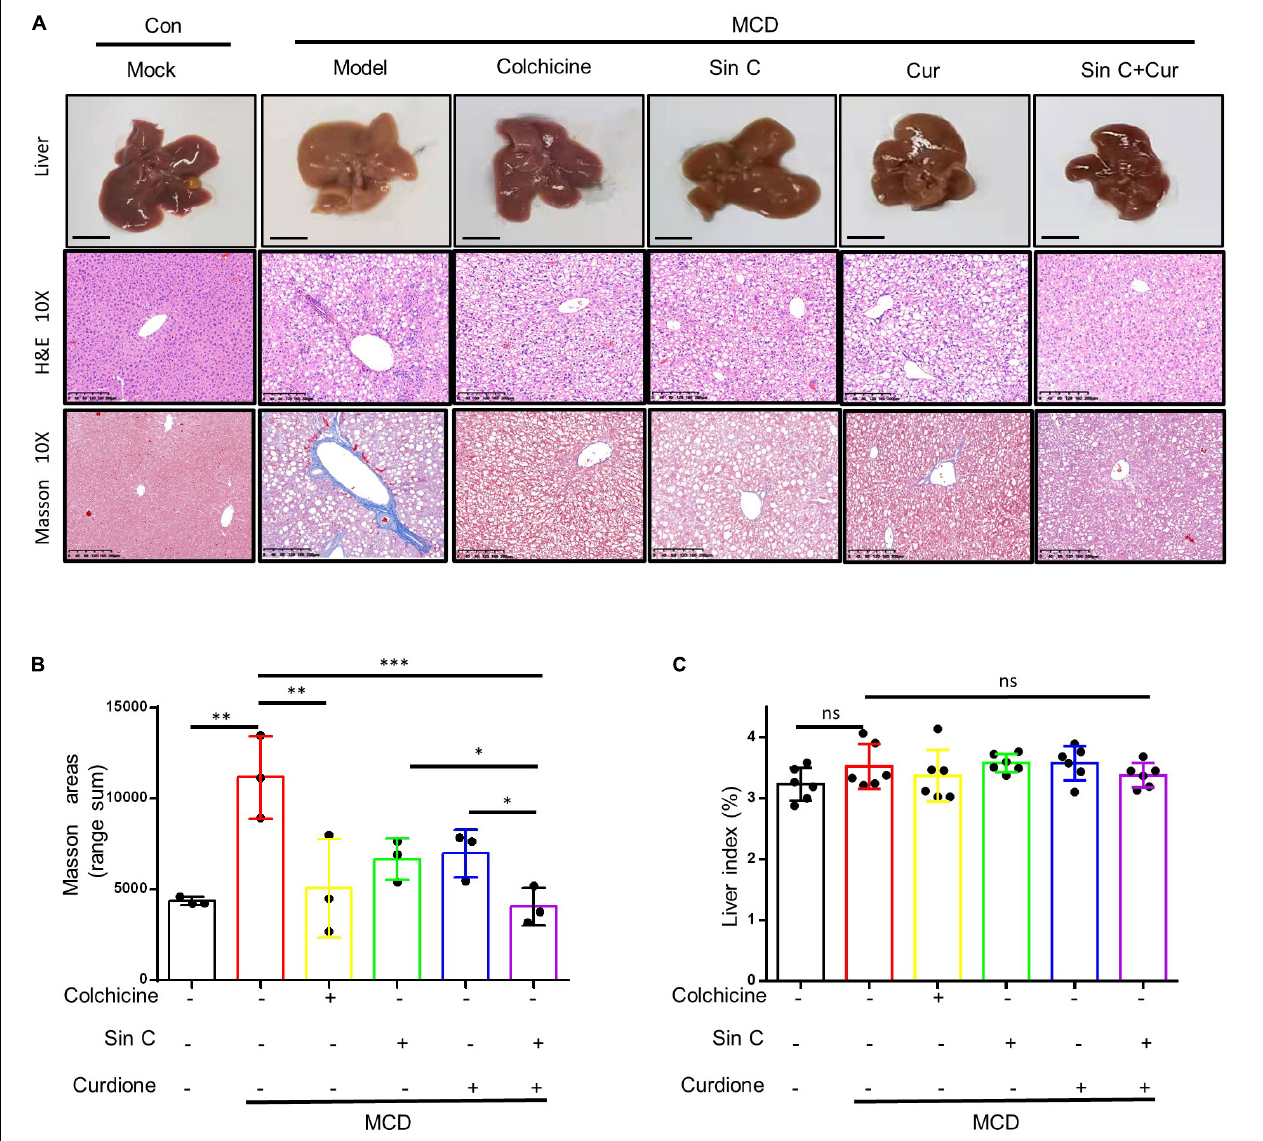
FIGURE 4 | The combination of Sin C and Curdione treatment significantly improved the histopathological changes in the liver of mice induced by MCD feed. The mice were pretreated with SinC, Curdione or combination of SinC and Curdione vehicle by gavage and fed with MCD feed for 6 weeks. Histopathological changes in the liver (A) , Scale bars represent 200 µ m Quantitative results of Masson staining sections (B) and liver coefficients (C) . Data are expressed as the mean ± SD from three independent mice samples (A,B) , * p < 0.05, ** p < 0.01, and *** p < 0.001; ns, not